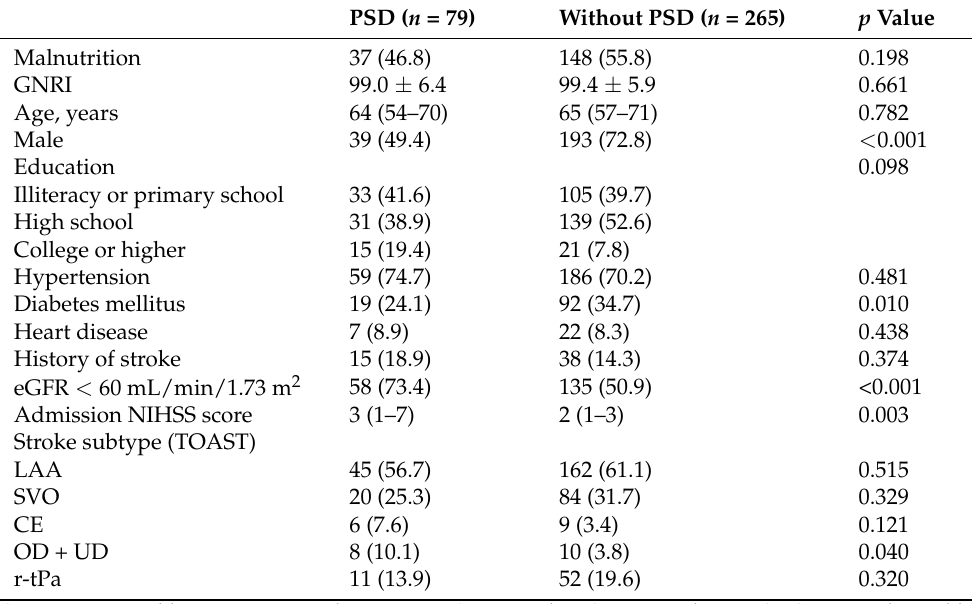
Table 1. Baseline characteristics of participants, according to the presence of post-stroke